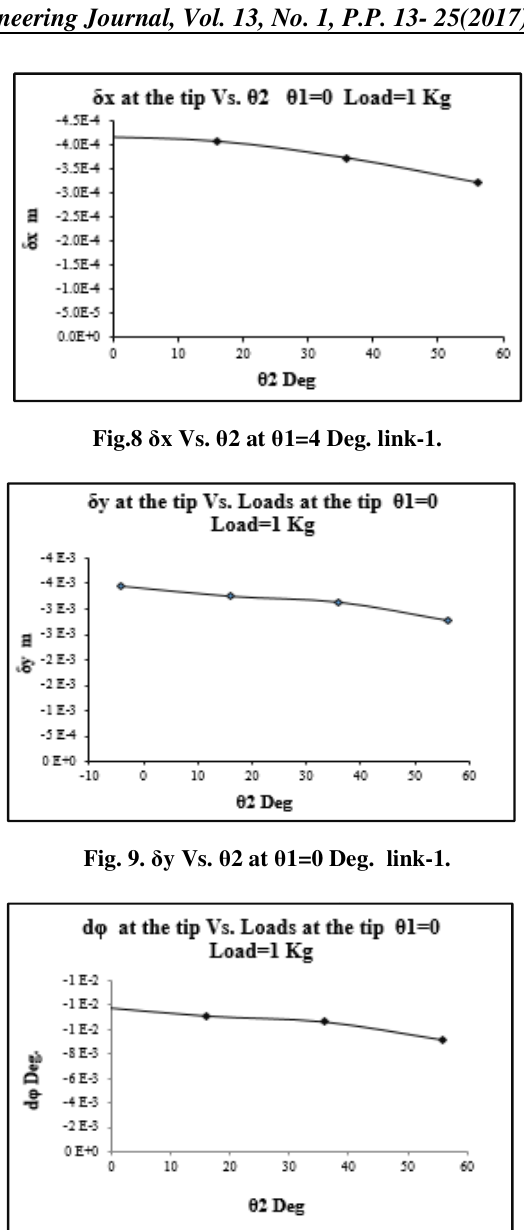
Fig. 7. samples of positions during experimental work.